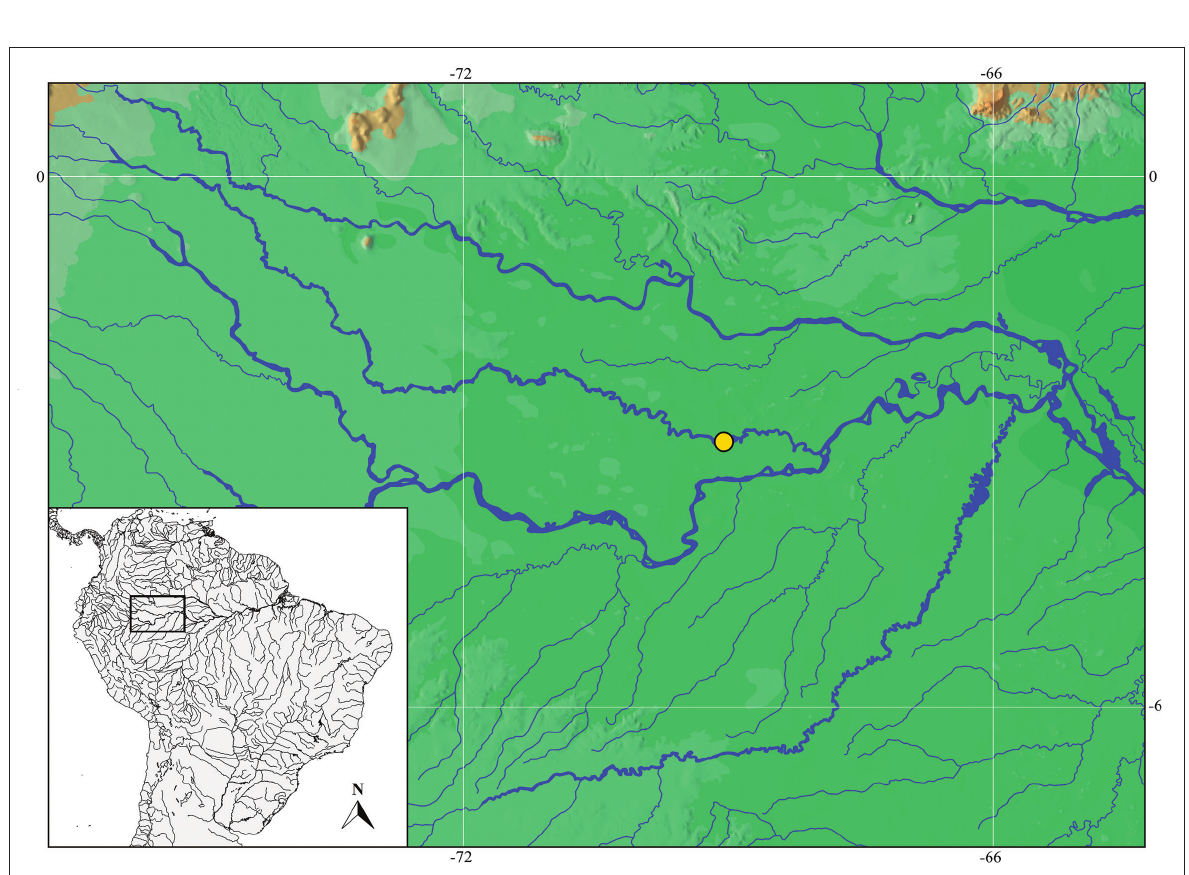
Figure 6. Partial map of South America with yellow circle indicating the distribution of Moenkhausia britskii